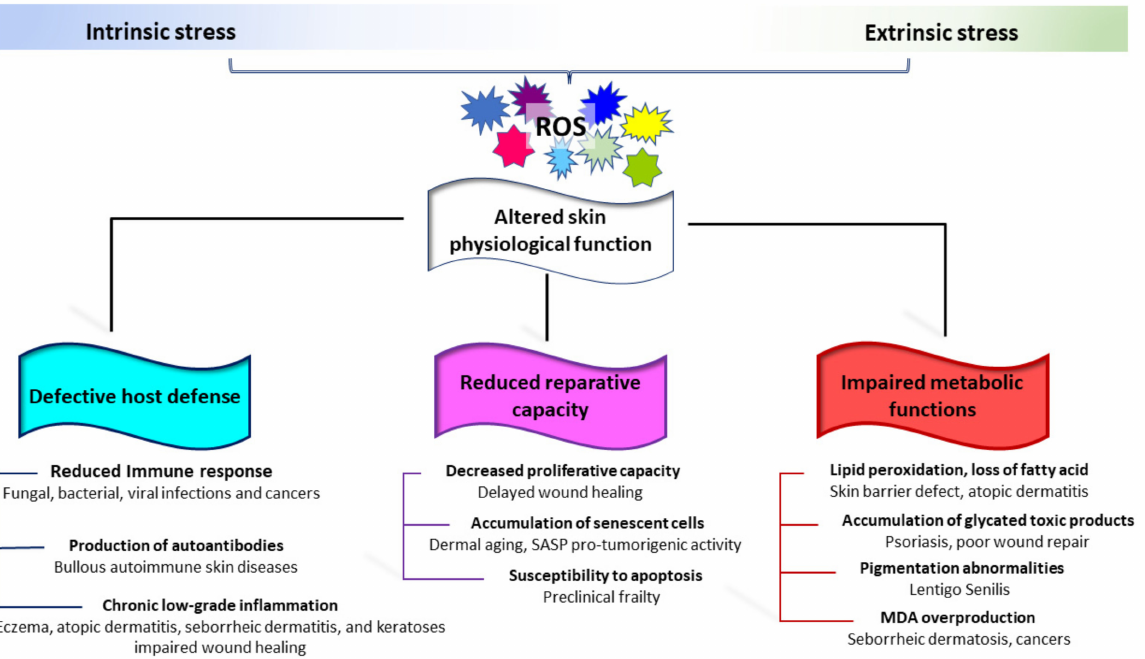
Figure 4. Schematic representation of the involvement of oxidative stress in common age-related skin diseases. Progressive structural and functional degeneration of the skin leaves it prone to a wide variety of very common cutaneous diseases. The onset of most of these clinical conditions involves extrinsic activation of cutaneous immune cells in a redox-dependent manner. This includes a reduced immune response, production of autoantibodies, and chronic low-grade inflammation. Structural, biochemical changes, accumulation of senescent cells, and age-related stem cell depletion impact the cutaneous repair capacity. Metabolic alterations in aged skin do not fully support the physiological function of the skin and its